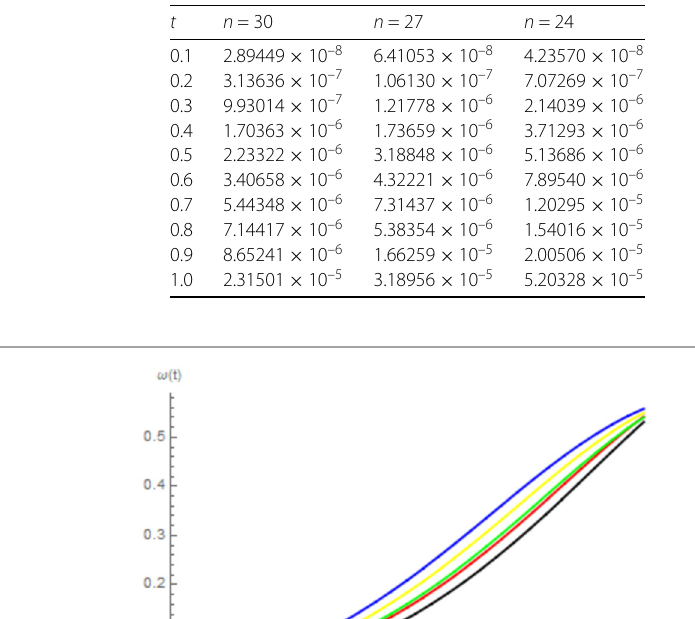
Table 4 Residual error Res( t ) of Example 5.2 for α = 1